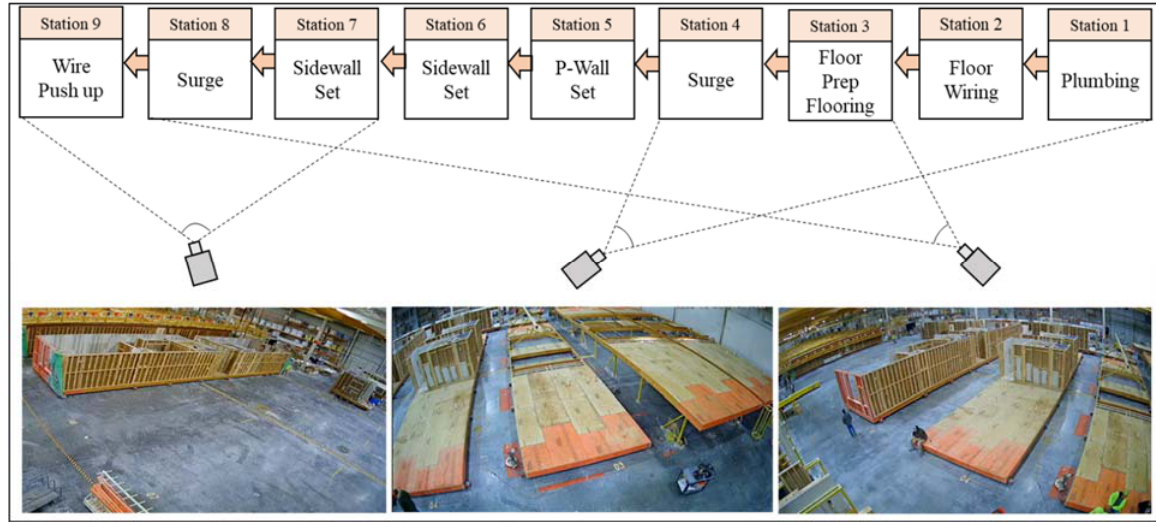
Figure 11. Surveillance camera view.